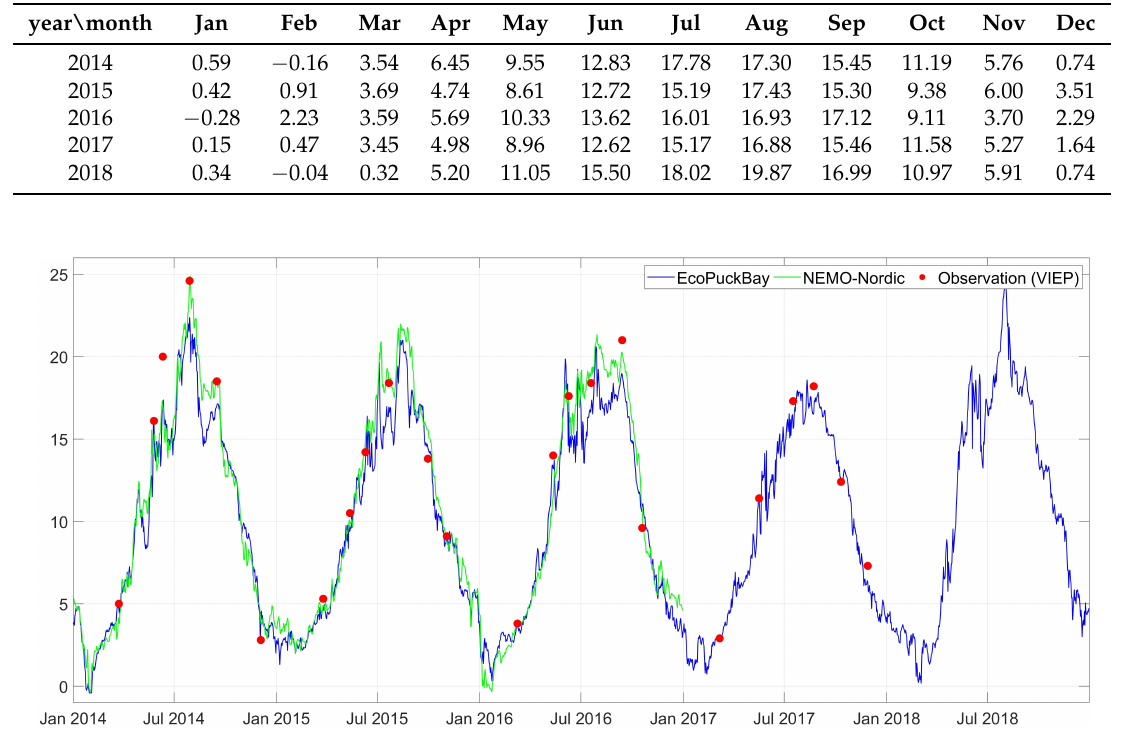
Figure A5. Time series of surface water temperature on station T16 compared with VIEP observations and NEMO-Nordic model.